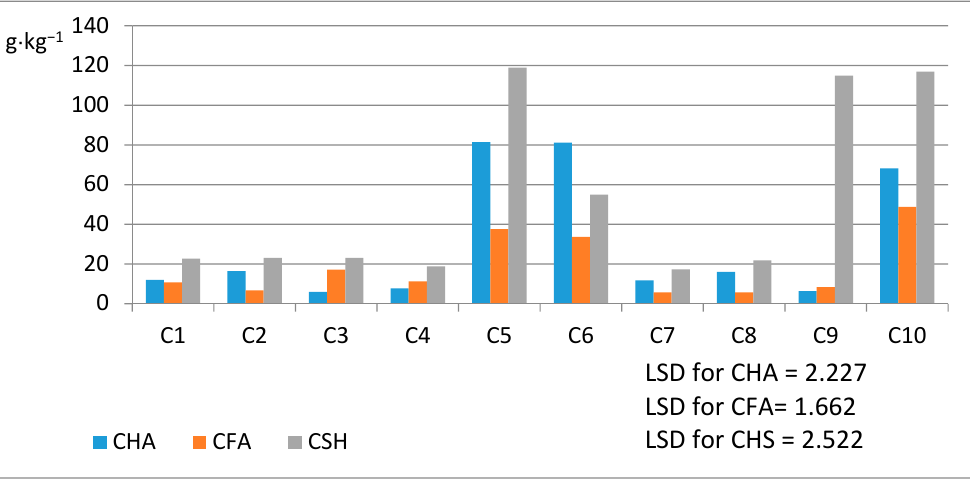
LSD for CHA = 2.227 LSD for CFA= 1.662 LSD for CHS = 2.522